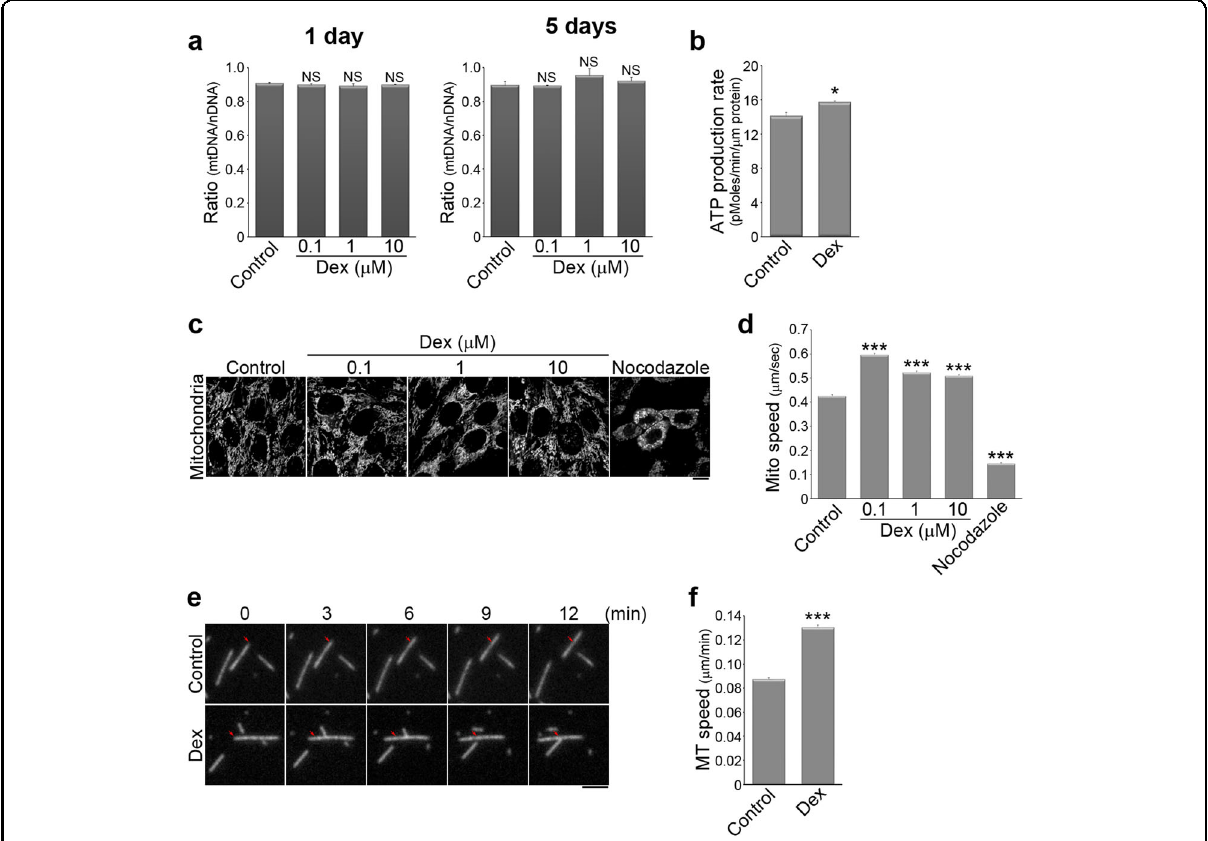
Fig. 1 Dexamethasone promotes mitochondria dynamics and enhances kinesin-1 motor activity. a C2C12 cells treated with DMSO (control), 0.1, 1, or 10 µM Dex in differentiation medium for 1 day or 5 days had their mitochondrial numbers assessed using the ratio of cytochrome C oxidase I DNA (to indicate mitochondrial DNA; mtDNA) to 18S rRNA DNA (to indicate nuclear DNA; nDNA) by real-time PCR. Data are mean ± s.e.m ( n = 3 independent experiments). NS no signi fi cance (compared with the control). b ATP production rate was calculated from oxygen consumption rate (OCR) in C2C12 cells treated with DMSO (control) or 1 µM Dex for 6 h. OCR was measured continuously followed by the addition of oligomycin (1 µM), Carbonyl cyanide 4-(tri fl uoromethoxy) phenylhydrazone (FCCP; 1 µM), and antimycin A (0.5 µM) with rotenone (0.5 µM) using Seahorse XF e 24 Extracellular Flux Analyzer. Data are mean ± s.e.m ( n = 3 independent experiments). * p < 0.05 (compared with control). c C2C12 cells treated with DMSO (control), 0.1 µM Dex, 1 µM Dex, 10 µM Dex for 1 h, or with 10 µM nocodazole for 16 h were stained with MitoTracker Red to visualize mitochondria. Scale bar, 10 µm. d Comparison of the average values for the speed of mitochondrial movement in C2C12 cells. Data are mean ± s.e.m (control, n = 3638 mitochondria/5 cells; 0.1 µM Dex, n = 5016 mitochondria/6 cells; 1 µM Dex, n = 3635 mitochondria/6 cells; 10 µM Dex, n = 4818 mitochondria/6 cells; nocodazole, n = 632 mitochondria/2 cells). *** p < 0.001 (compared with the control). e Time-lapse epi- fl uorescence microscopy showing the movement of rhodamine-labeled microtubules treated with control (DMSO) or 1 µM Dex, using in vitro kinesin-1 motility assay. Scale bar, 2 µm. f Comparison of the average values for the speed of microtubule movement brought about by kinesin-1. Data are mean ± s.e.m (control, n = 494 microtubules; 1 µM Dex, n = 370 microtubules). *** p < 0.001 (compared with